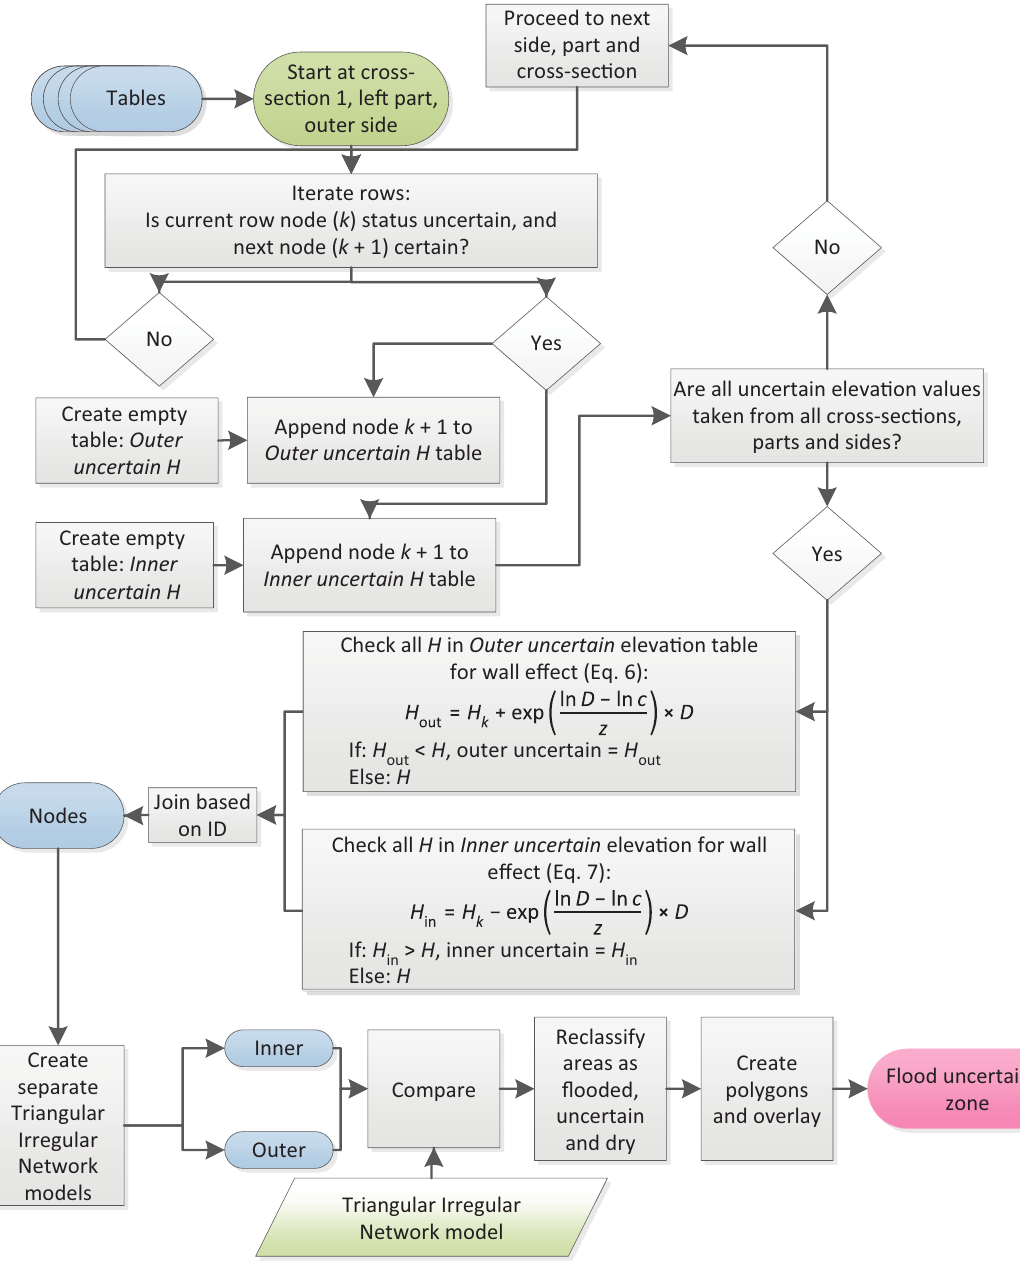
Figure 4. Implementation of the algorithm and generation of the uncertainty zone. stretching from Åmot in Ockelbo municipality